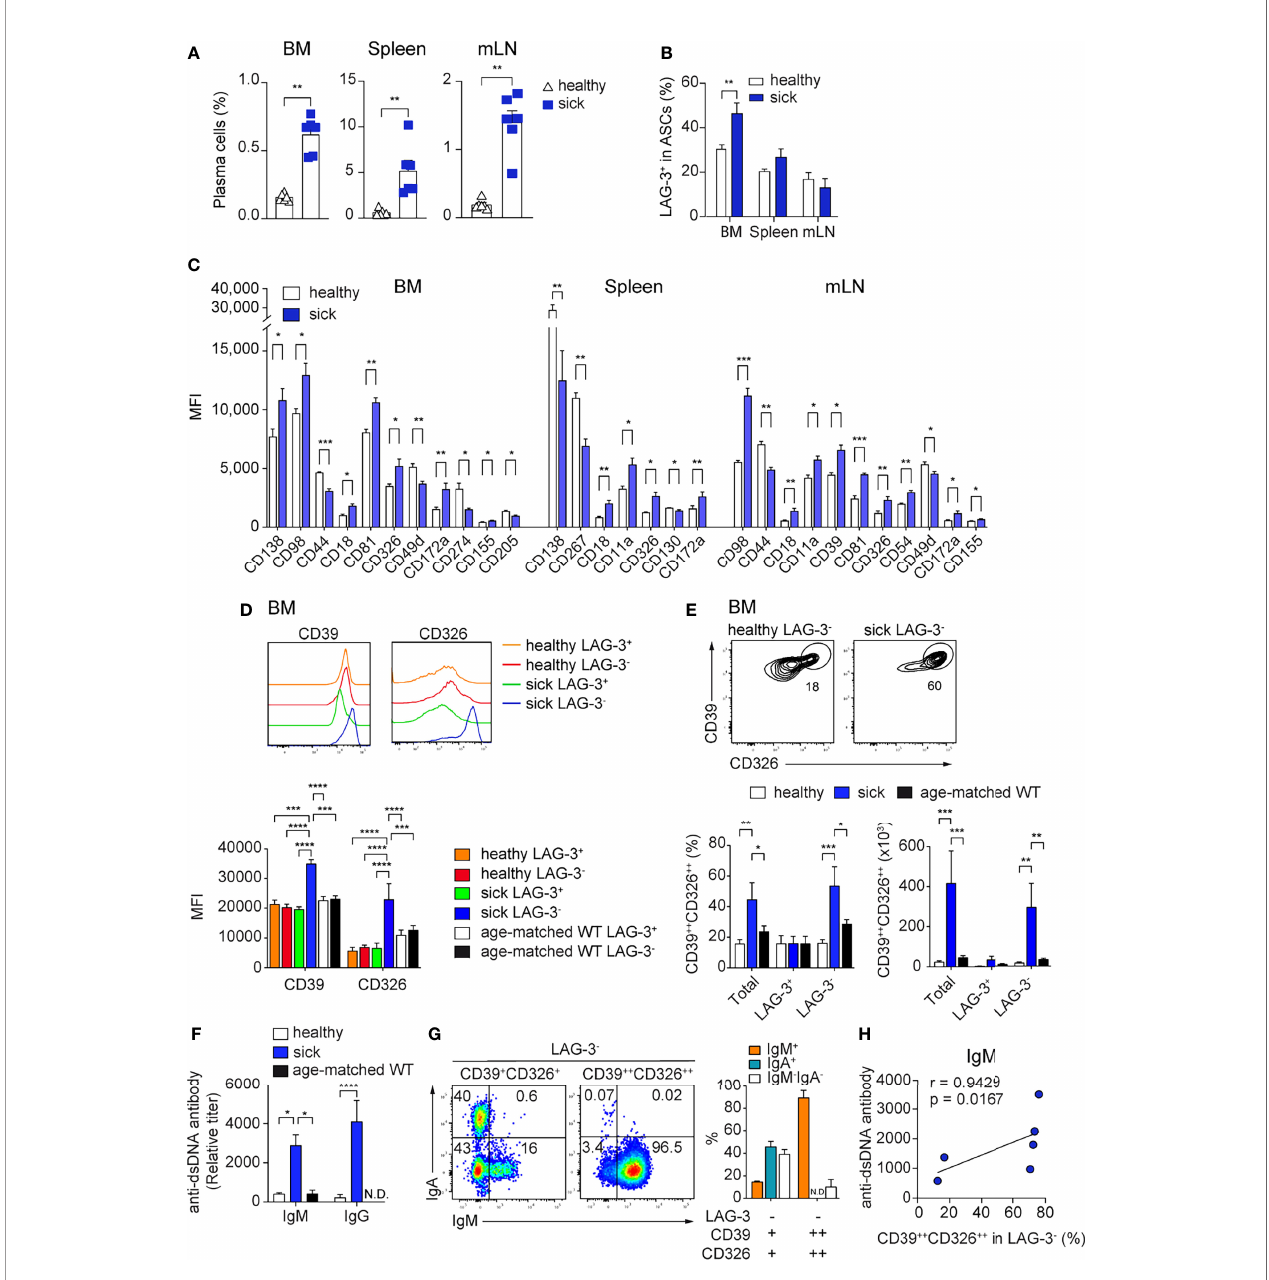
FIGURE 6 | High CD39 and CD326 surface expression identi fi es a BM speci fi c ASC subpopulation in SLE. Sle123 mice with proteinuria >100mg/dL (A – C) and >300mg/dL (D – G) were analyzed. Age-matched WT and healthy mice (2-3 months) without proteinuria were included as controls. (A, B) Frequencies of ASCs de fi ned by co-expression of CD138 and CD39 (A) and frequencies of LAG-3 + cells within ASCs (CD138 + CD39 + ) of healthy versus sick Sle123 mice (B) . (C) Comparison of the expression levels (MFI) of indicated markers on CD138 + CD39 + ASCs from healthy versus sick Sle123 mice (markers lacking signi fi cant differences are not shown). (D) Representative histograms (top) and quanti fi cation (bottom) of the expression of CD39 and CD326 by LAG-3 + and LAG-3 - ASCs in BM of healthy and sick Sle123 and age-matched WT. (E) Representative FACS plots (top) showing a subpopulation co-expressing CD39 and CD326 within LAG-3 - ASCs in BM of sick Sle123 compared with healthy controls. The graphs show frequencies (left bottom) of CD39 ++ CD326 ++ in total, LAG-3 + or LAG-3 - ASCs, and numbers (right bottom), in BM of healthy and sick Sle123 and age-matched WT. (F) Anti-dsDNA autoantibody titers from healthy versus sick Sle123 and age-matched WT mice detected by ELISA. (G) Representative FACS plot (left) and graph (right) showing the immunoglobulin isotypes in LAG-3 - CD39 + CD326 + and LAG-3 - CD39 + + CD326 ++ from BM of sick Sle123 . (H) Spearman correlation between the frequencies of CD39 ++ CD326 ++ within LAG-3 - ASCs and anti-dsDNA antibody titer for IgM. Data show compilation of at least two independent experiments (n=6-10 mice/group). Groups were compared using unpaired t test with Welch ’ s correction (A, B) , multiple unpaired t test with Welch correction followed by Holm-S ̌ ida ́ k ’ s multiple comparisons test (C) , two-way ANOVA followed by Dunnett ’ s multiple comparisons test (D-F). Data show mean ± SEM ( ∗ p < 0.05, ∗∗ p < 0.01, ∗∗∗ p < 0.001, ∗∗∗∗ p < 0.0001). P values > 0.05 are not